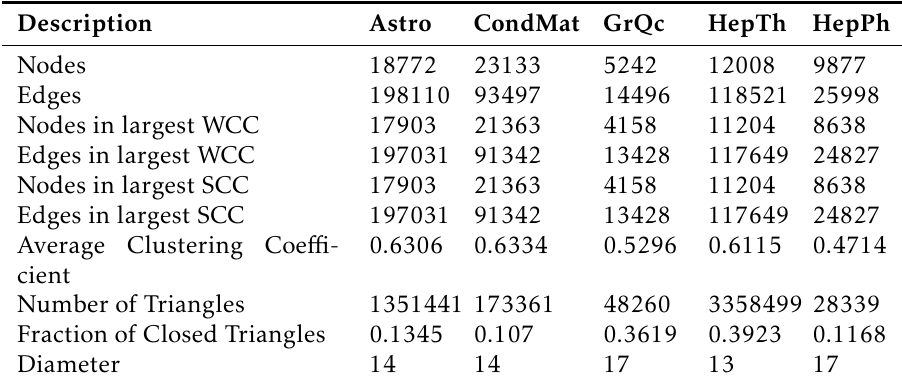
Table 2. Statistics of all dataset used in the